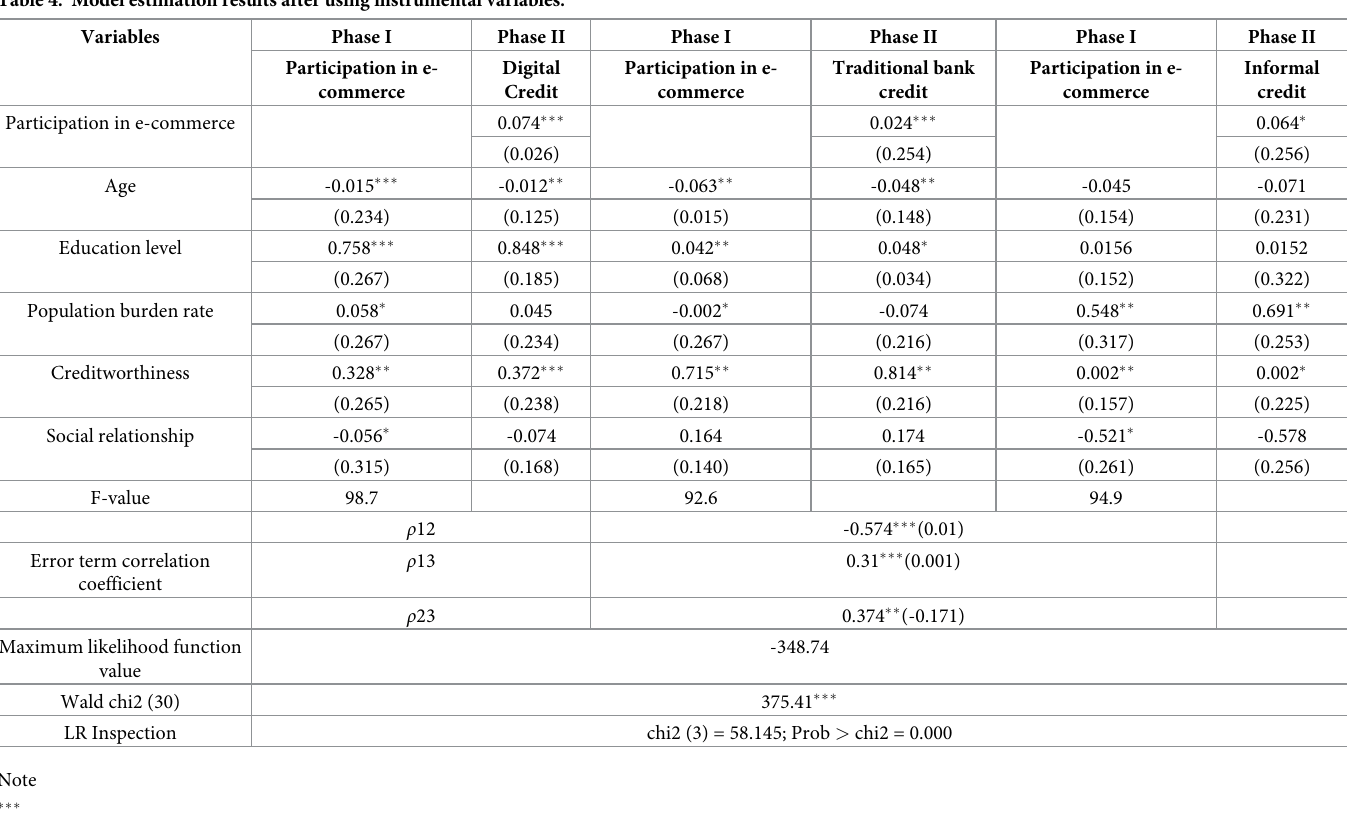
Table 4. Model estimation results after using instrumental